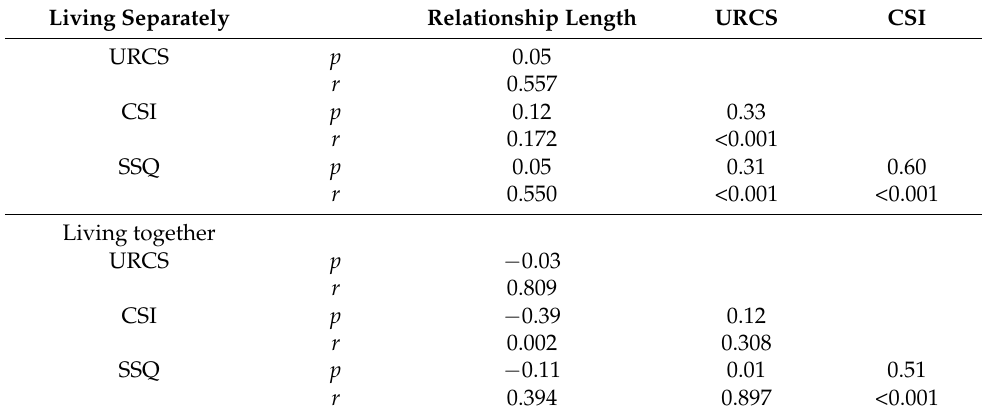
Table 5. Correlation matrix in psychological factors in people living together or separately.